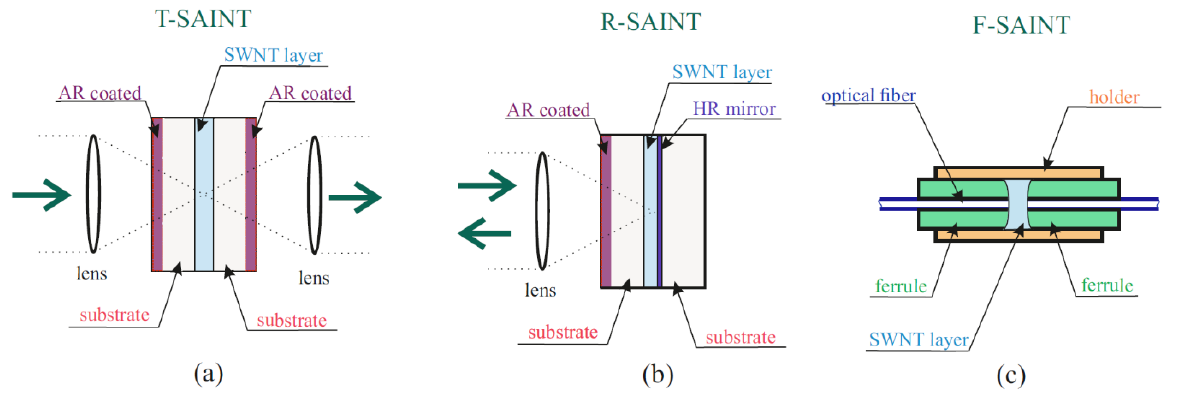
Figure 16. Modules with nanotubes as a saturable absorber: ( a ) transmissive (T-SAINT), ( b ) reflective (R-SAINT), and ( c ) fiber (F-SAINT).